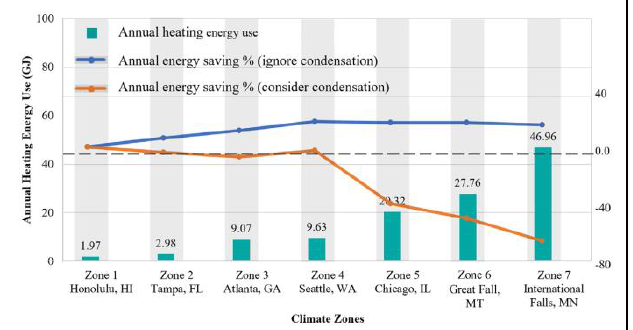
Figure 30. Annual Heating Energy Use and Associated Energy Savings Trends